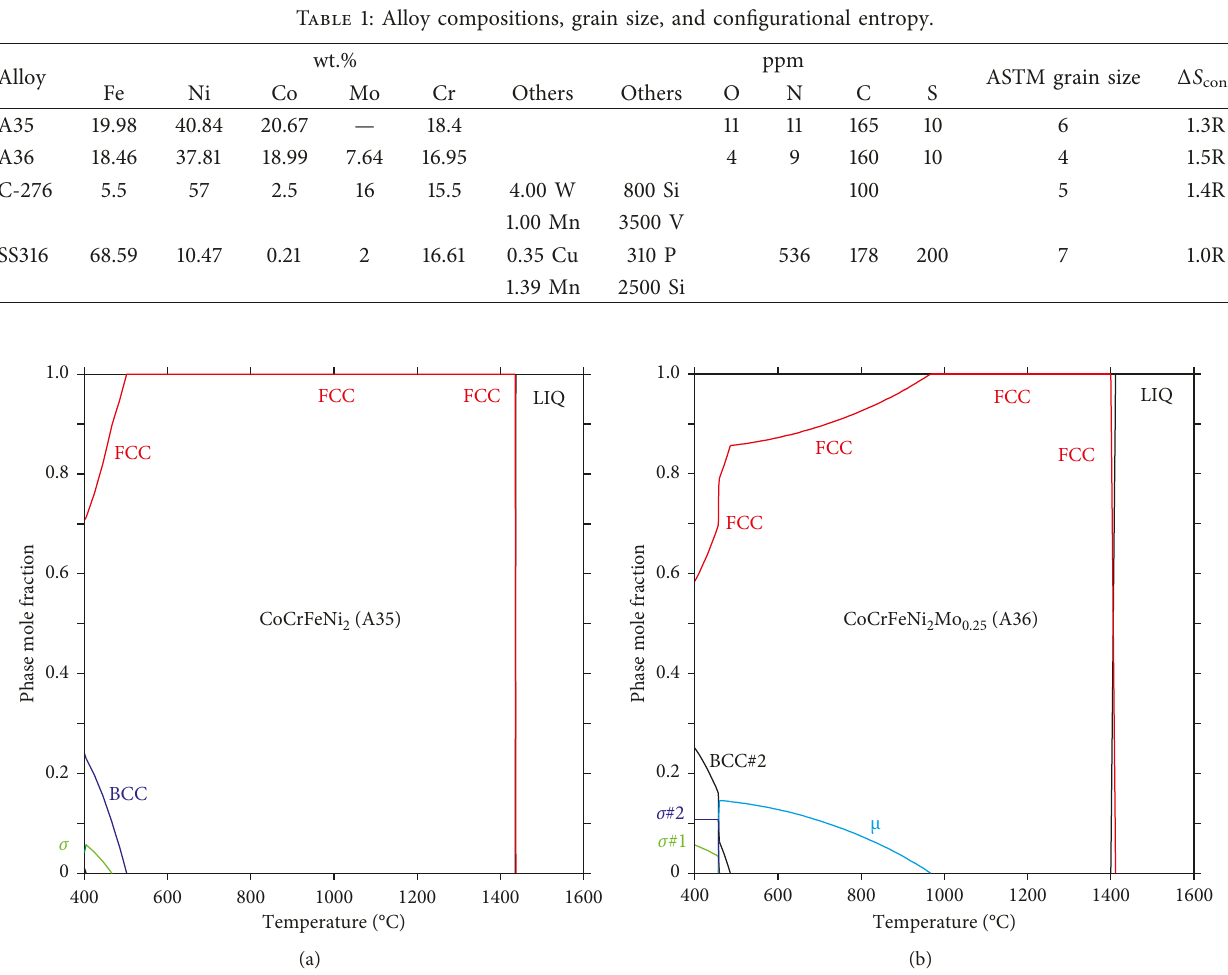
Figure 1: Calculated equilibrium phase mole fraction versus temperature for (a) CoCrFeNi using the bulk composition provided in Table 1 (only the elements Co, Cr, Fe, Ni, and Mo were